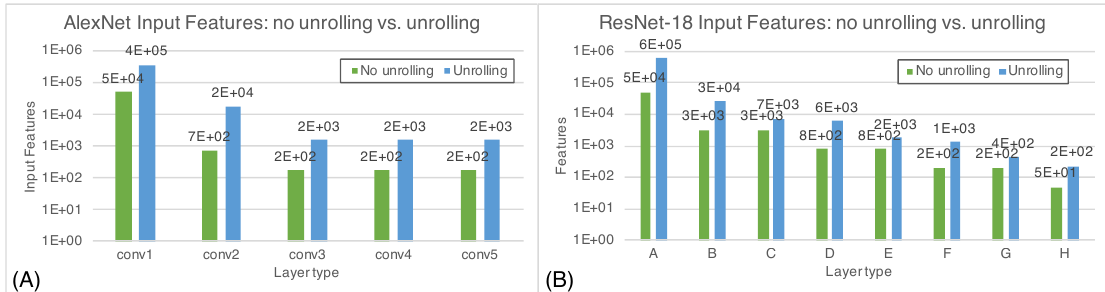
Figure 8. Data redundancy caused by unrolling in ( A ) AlexNet and ( B ) ResNet-18. Green columns represent the number of input features when applying no unrolling, blue columns represent the number of input features when applying unrolling. Input features are shown for each convolutional layer.